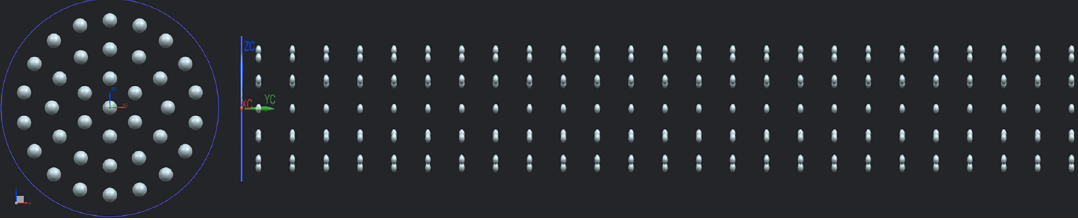
Fig 1. In this study phantoms with varying porosities in radial (left) and axial (right) direction were manufactured. The radial distributionis identifiedby the numberof pores in the cross-section (here 37), and the axial distribution is identifiedby the numberof such patterns along the axis (here 25).